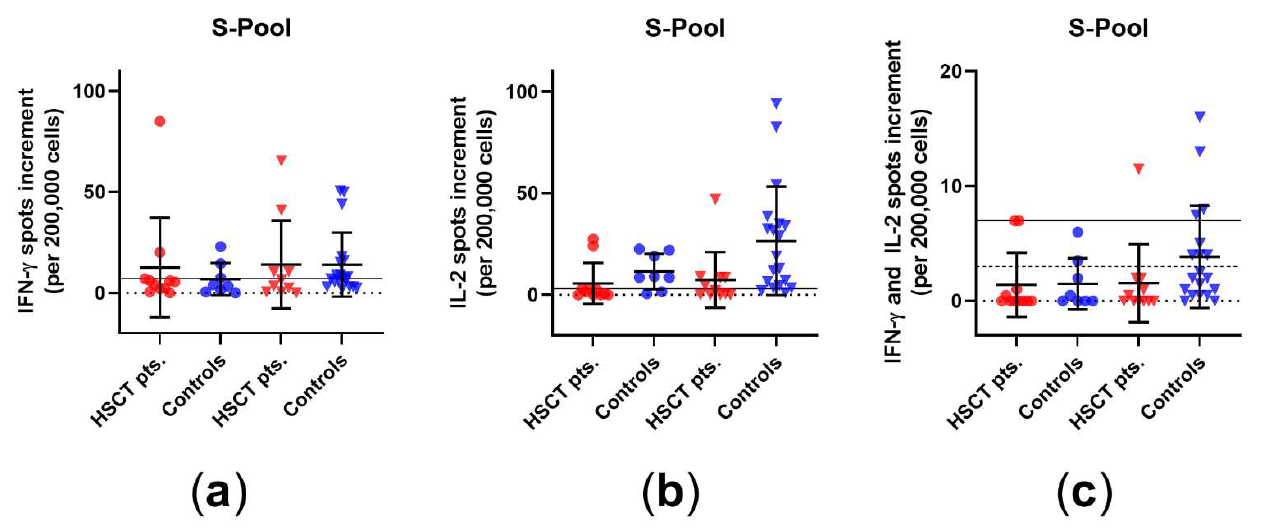
Figure 1. SARS-CoV-2-specific CoV-iSpot responses in HSCT patients and healthy controls before and after the third vaccination. Distribution of ( a ) IFN-γ, ( b ) IL-2, and ( c ) simultaneous IFN-γ and IL-2 CoV-iSpot responses upon stimulation with S pool of wildtype SARS-CoV-2. Please note that the scales differ. Circles indicate data before the third vaccination (red: HSCT, blue: healthy controls), while triangles indicate data after the third vaccination. Responses before and after the third vaccination were compared by two-tailed Mann–Whitney test. Horizontal lines indicate mean values, while error bars indicate the standard deviation. The dotted line represents the zero line. The black horizontal line indicates the cutoff. In panel ( c ), the continuous line indicates the cutoff for IFN-γ, while the dashed line indicates the cutoff for IL-2.